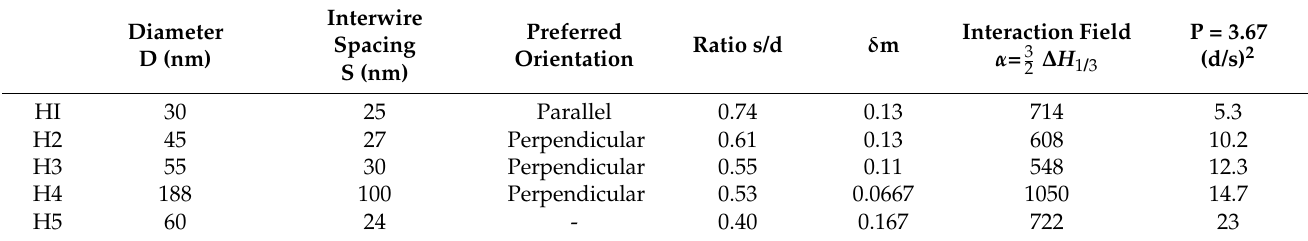
Table 2. A summary of nanowires’ dimensions used in this study. Where δ m = m o − 1/3 and ∆ H 1/3 manifests interaction field among nanowires. Diameter D